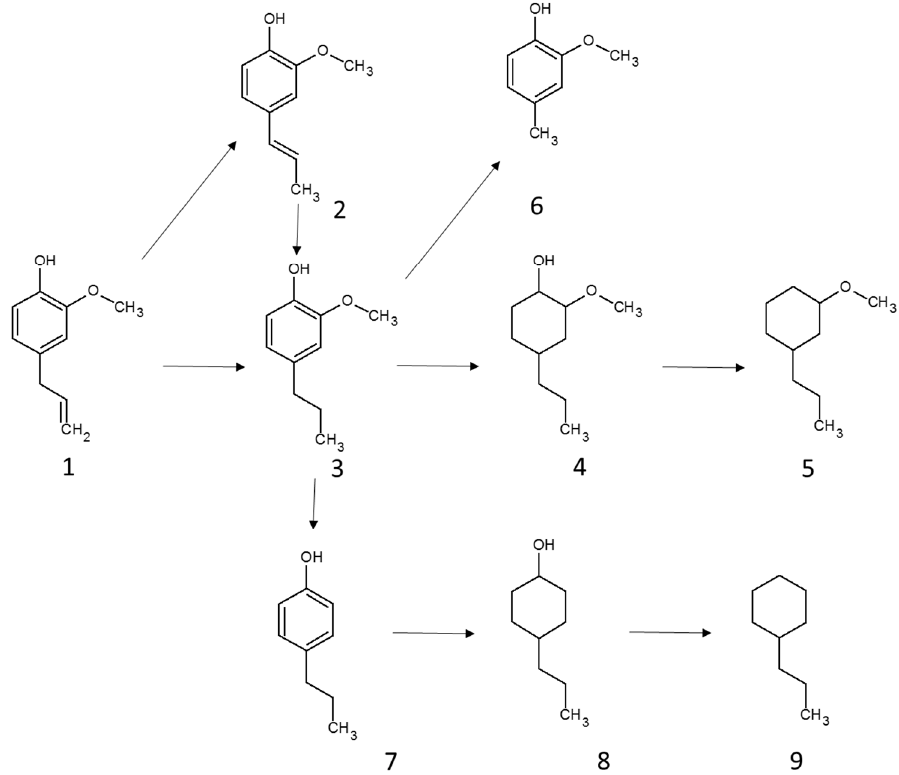
Figure 10. Reaction scheme for eugenol HDO over various Pd catalysts supported on Al 2 O 3 , SiO 2 , carbon and aluminosilicate under 30 bar hydrogen at 250 °C in hexadecane as a solvent adapted from reference [49]. Notation: 1. Eugenol, 2. Isoeugenol, 3. 2 ‐ methoxy ‐ 4 ‐ propylphenol, 4. 2 ‐ methoxy ‐ 4 ‐ propylcyclohexanol, 5. 3 ‐ propylmethoxycyclohexane, 6. 4 ‐ methyl ‐ 2 ‐ methoxyphenol, 7. 4 ‐